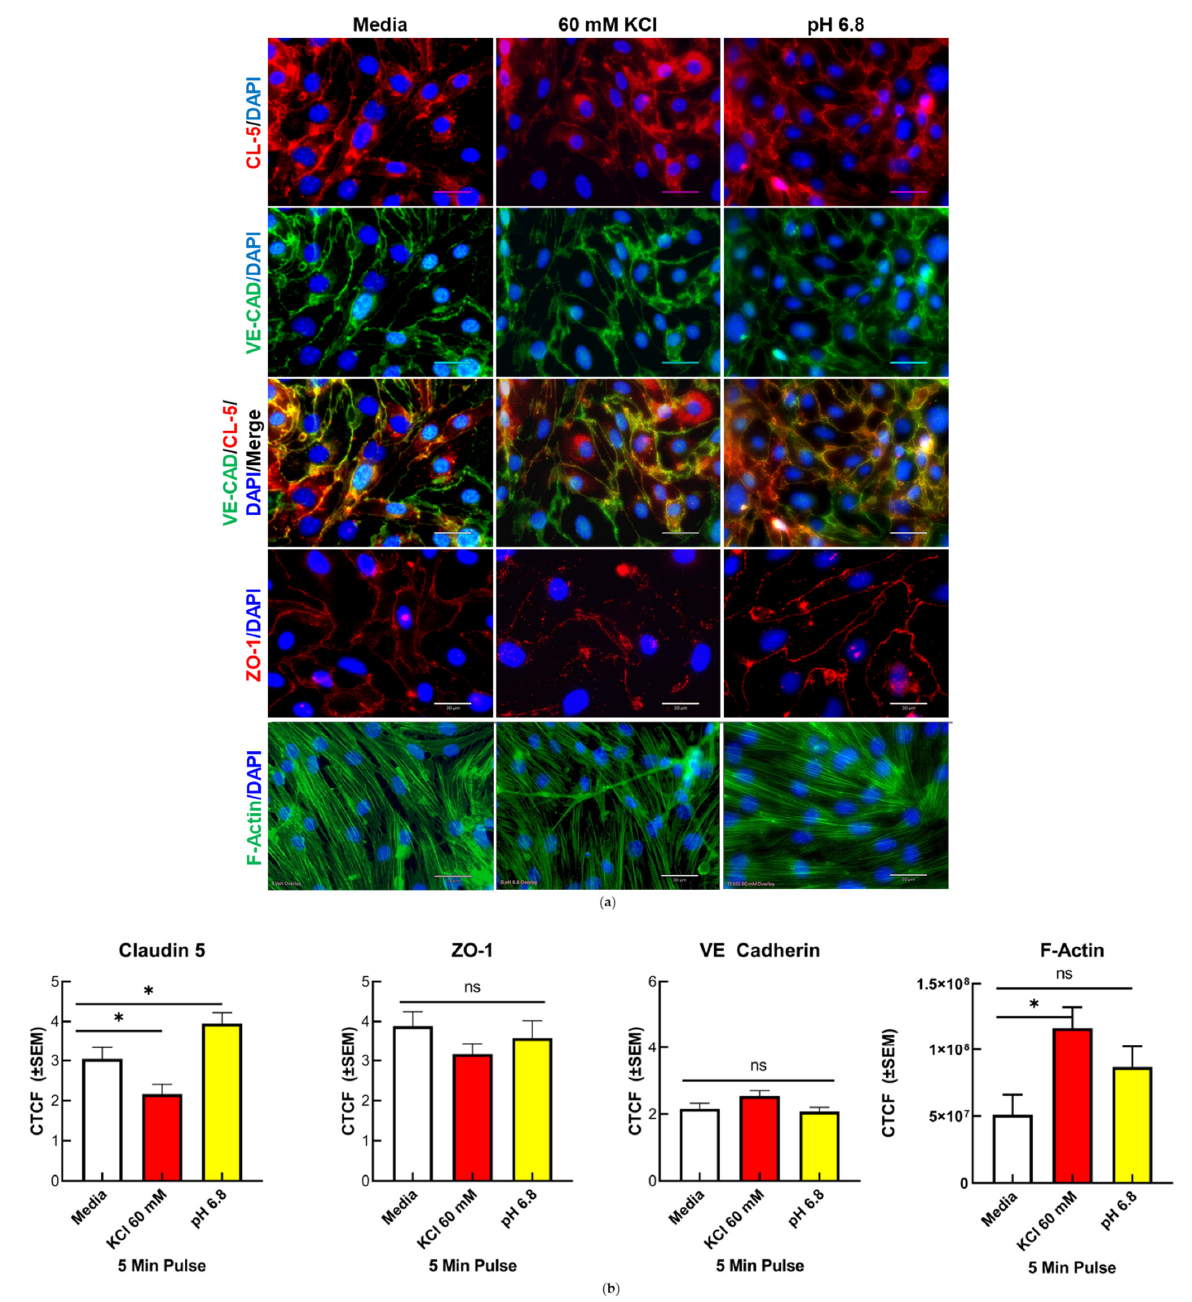
Figure 2. Localization of endothelial TJ associated proteins and visualization of F-actin fibers following KCl and acidified pH treatment in vitro. ( a ) Representative immunofluorescence images of b.End3 endothelial cells post 60 mM KCl and acidified pH treatment for CL-5, VE-CAD, ZO-1, and F-Actin, scale bar represents 30 μ m ( b ) Quantification of CL-5, ZO-1, VE-CAD, and F-Actin by corrected total cell fluorescence (CTCF). CL-5, but not ZO-1 or VE-CAD, demonstrated significant changes to total signal following KCl and acidified pH treatment, while F-actin was increased following KCl insult. CL-5: media vs. 60 mM KCl: mean rank difference = 25.20, Z = 2.107, * p = 0.0351, n1 = 34, n2 = 43: media vs. pH = 6.8: mean rank difference = − 21.48, Z = 1.942, * p = 0.0521, n1 = 34, n2 = 64; Kruskal–Wallis statistic: 36.25: ZO-1: media vs. 60 mM KCl: mean rank difference = 12.77, Z = 1.319, p = 0.1872, n1 = 25, n2 = 33; media vs. pH = 6.8: mean rank difference = 9.352, Z = 0.9384, p =